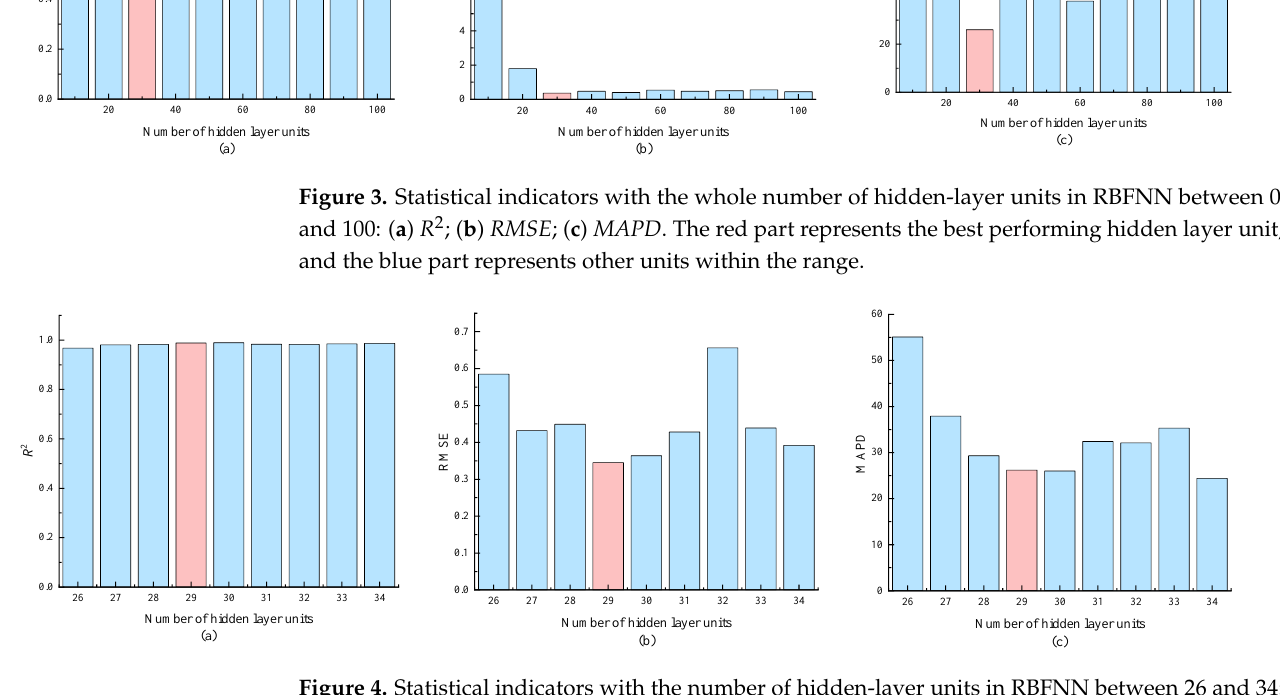
values using the BPNN method on the training and testing datasets, while Figure 6 shows the measured and predicted freezing-temperature values using the RBFNN method on the training and testing datasets. In both models, the predicted values were close to the experimental